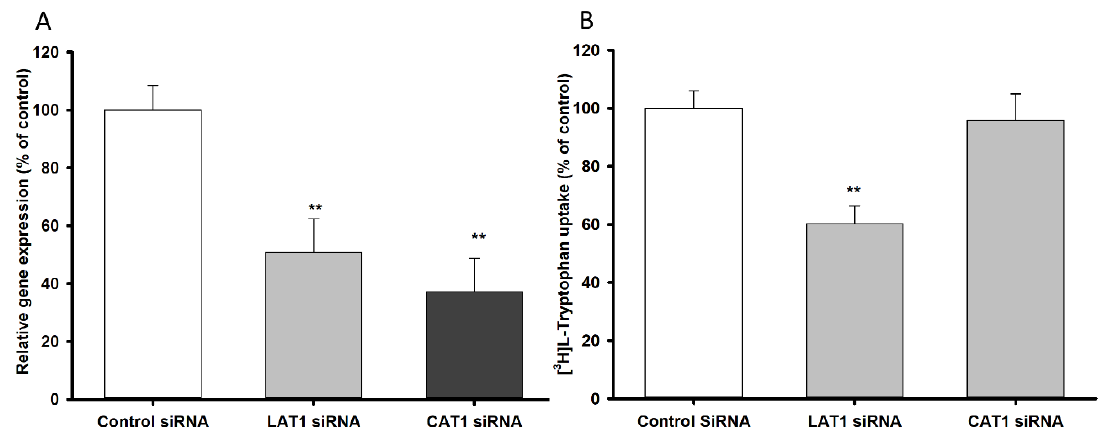
Figure 3. LAT1 and CAT1 siRNA knockdown effect on ( A ) mRNA expression and ( B ) [ 3 H] L -tryptophan uptake by TR-BBB cell lines. The siRNA transfection was carried out for 48 h, followed by mRNA expression and uptake study at 37 °C for 5 min. Each point represents the mean ± SEM ( n = 4). ** p < 0.01 indicates a significant difference from the control.